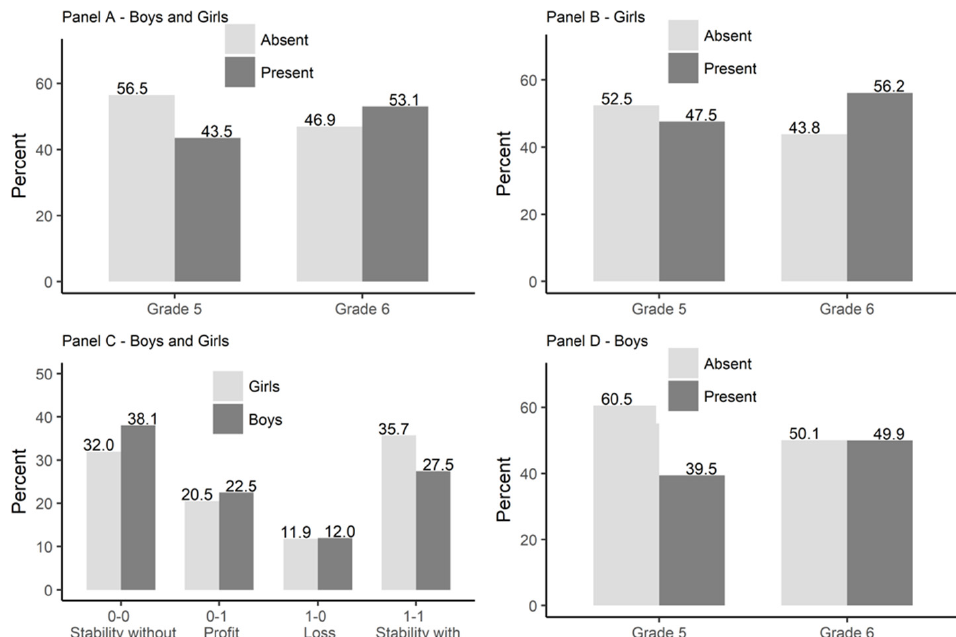
Figure 4. The charts illustrating the distribution of sex heterophily in both waves of the study. Note: Present = declared liking of a peer of the opposite sex; Absent = declared liking only people of their own sex; Stability without = did not nominate any peers of the opposite sex at the beginning of grade 5 and at the end of grade 6); Profit = did not nominate peers of the opposite sex in the first wave of the study but declared such “likes” later on in the second wave; Loss = liked somebody of the other sex at the beginning of grade 5, but did not declare the same type of “like” in grade 6; Stability with = showing heterophilic tendencies both in grade 5 and grade 6.